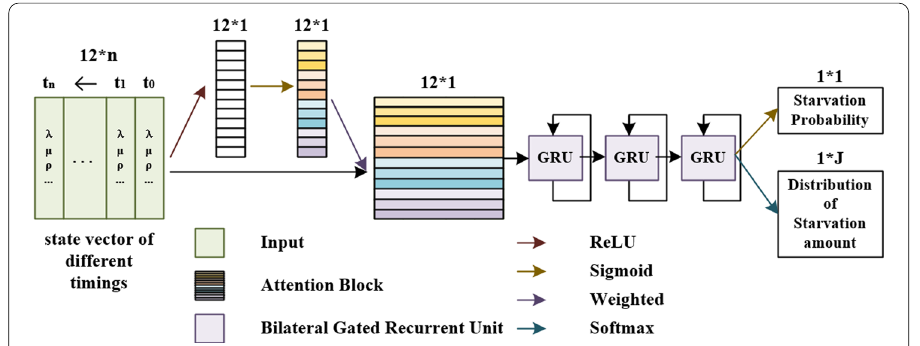
Fig. 1 Structure of the buffer starvation behavior evaluation model